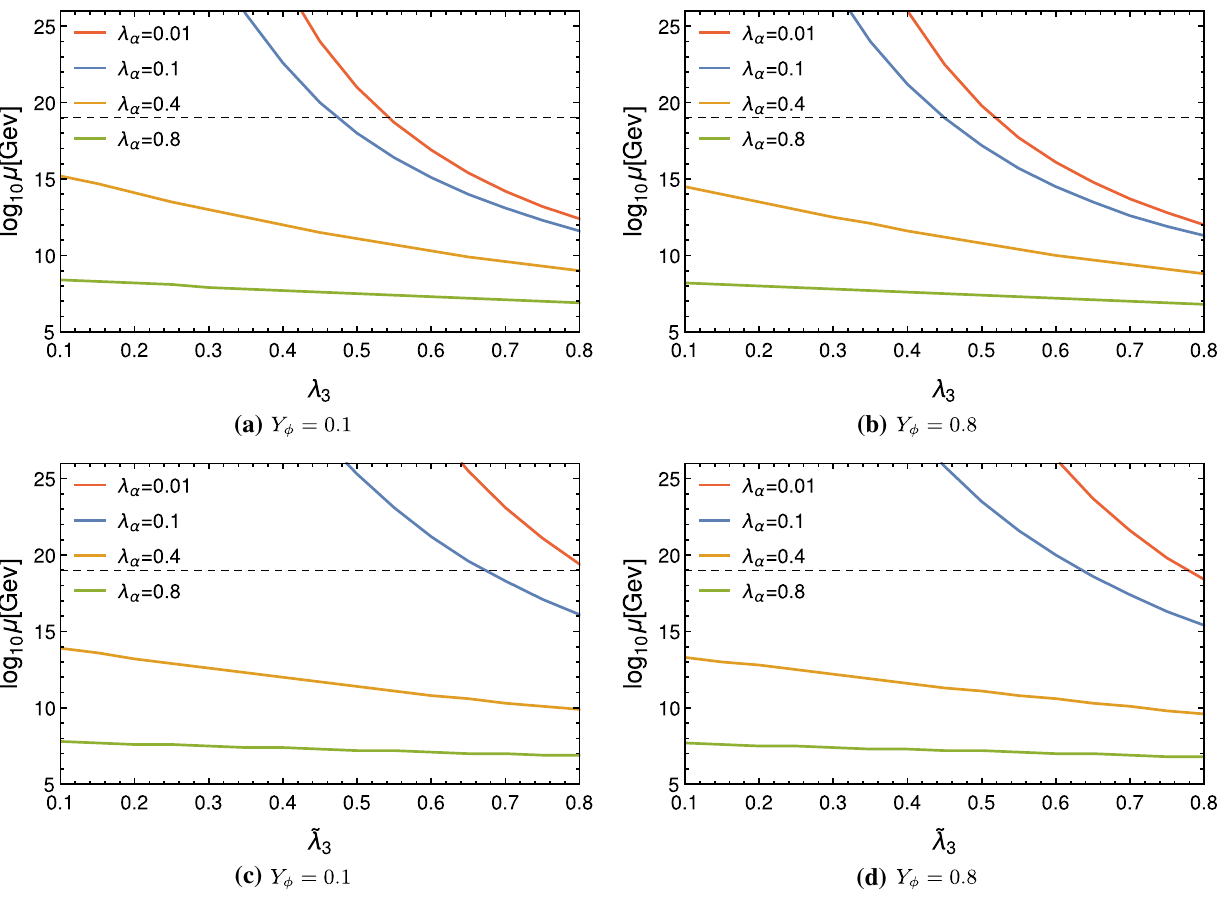
Fig. 8 Variation in triplet leptoquark-Higgs quartic coupling λ 3 and ent values of λ α at the EW scale, i.e. 0.01, 0.1, 0.4 and 0.8, which are (cid:2) R (cid:2) λ + S λ λ α ∈ denoted by red, blue, orange and green curves, respectively. The black 3 for one generation of 2 3 . Here, for the 3 variation, { λ , (cid:2) λ , (cid:2) λ } , and for (cid:2) λ λ α ∈ { λ , (cid:2) λ ,λ } . We consider four differ- dotted line parallel to the x -axis denotes the Planck 2 2 3 3 , 2 2 3